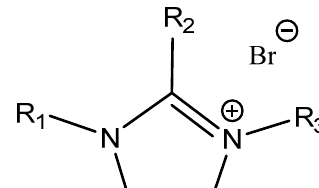
Figure 6. Structures of tested N,N ′ -dialkyl IM-based ILs in the carbonation of PO [64]. R 1 = Me; R 3 = Bu; R 2 = H = 1-methyl-3-butyl imidazolium bromide [BMIm]Br; R 1 = Me; R 3 = Bu; R 2 = Me = 1,2- R 1 = dimethyl-3-butylimidazolium bromide [BM 2 Im]Br; R 1 = Me; R 3 = Bu; R 2 = Et = 1-methyl-2-ethyl-3- butylimidazolium bromide [BEMIm]Br; R 1 = Me; R 3 = Oct; R 2 = H = 1-methyl-3-octylimidazolium bromide [OMIm]Br; R 1 = Me; R 3 = Oct; R 2 = Me = 1,2-dimethyl-3-octylimidazolium bromide [OM 2 Im]Br; R 1 = Me; R 3 = Oct; R 2 = Et = 1-methyl-2-ethyl-3-octylimidazolium bromide [OEMIm]Br;